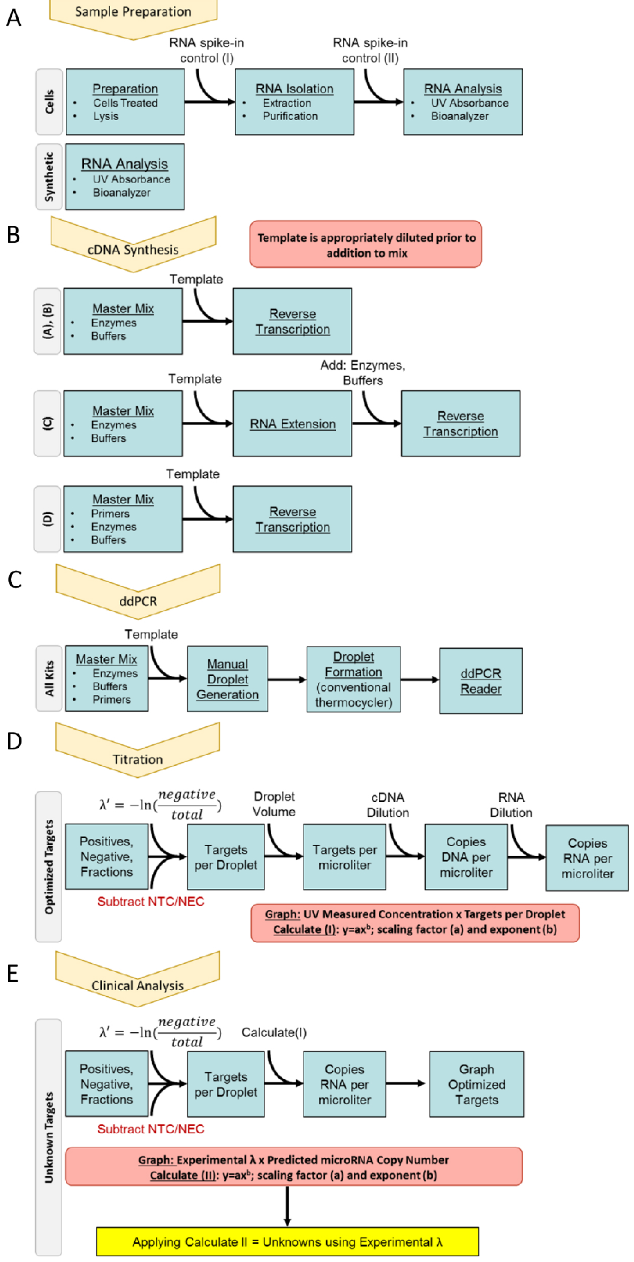
Fig 1. Procedure for analyzing microRNA(miRNA) in a clinical sample. (A) Preparesamples either by isolatingtotal RNA from cells or acquiringsynthetic miRNA oligonucleotides. miRNA spike-in controls are added at different points within the RNA extraction process to control for loss of material associatedwith different steps. (B) cDNA is synthesized using miRNA-specific cDNA synthesis kits. The kits contain reagents that will add adaptor sequencesonto the target miRNA so that primers and probes can respectivelybind either duringcDNA synthesis or duringPCR steps. All cDNA synthesis kits show signs of non-specific cDNA products so it is recommended to create one reaction without RNA template (NTC) and one reactionwithout enzymes (NEC) for each round of cDNA synthesis. (C) Droplet digital PCR (ddPCR)is doneby taking the cDNA synthesizedfrom miRNA template and creatingwater-in-oildroplets that each containzero to a few target sequences. The cDNA template might need to be dilutedto obtain the optimalnumber of targets per droplet. Results are reportedas florescenceintensity. Either the user or the instrument software can definea threshold. Droplets that fluoresceat an amplitudehigherthan the definedthreshold will be positive for target sequenceand those belowthresholdare negative for target sequence[16]. (D) Average fraction positive